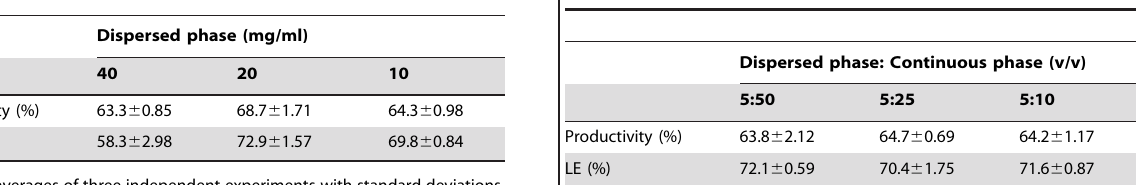
Table 3. Comparison of volume ratio between dispersed phase and continuous phase a .